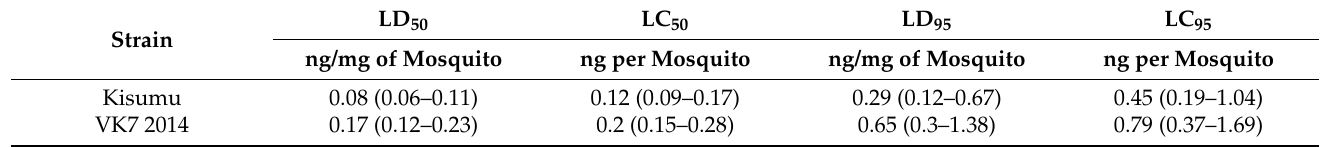
Table 1. Lethal doses and lethal concentrations of dinotefuran ingested in a sugar solution in two strains of Anopheles mosquitoes. 95% CI given in parentheses. Kisumu is a lab strain of Anopheles gambiae , VK7 2014 is An. coluzzii